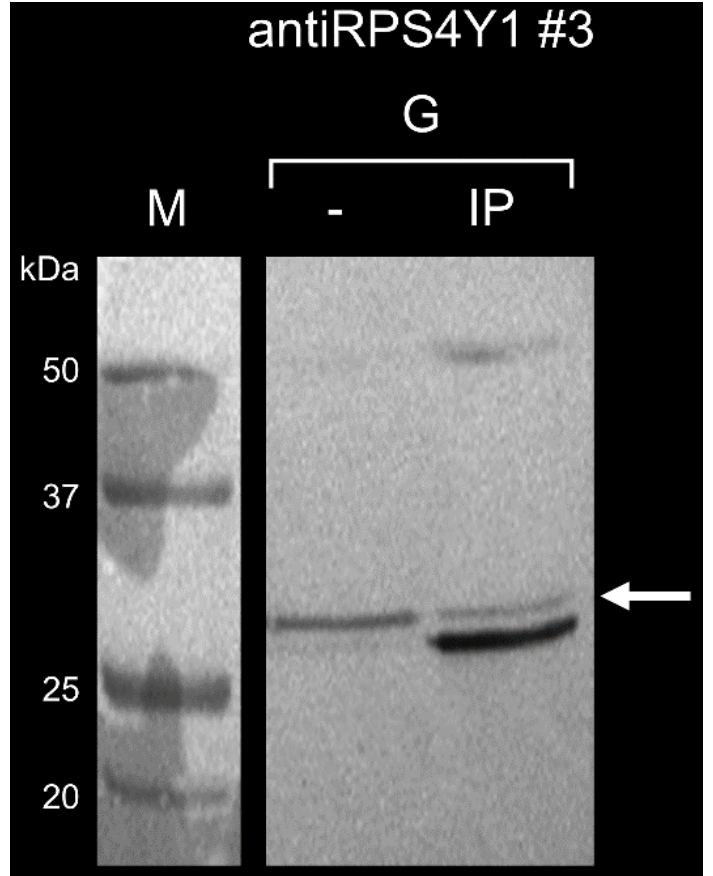
Figure 5. mRPS4Y1#3 antibody binding to the native RPS4Y1 protein. Representative results of immunoprecipitation experiments (one out of three) of RPS4Y1-antibody#3 complex performed with magnetic beads coupled to protein G (G) are showed. Immunoprecipitated proteins (IP) and supernatants (–) were loaded and analyzed by SDS-PAGE and Western blotting. The arrow indicated the RPS4Y1